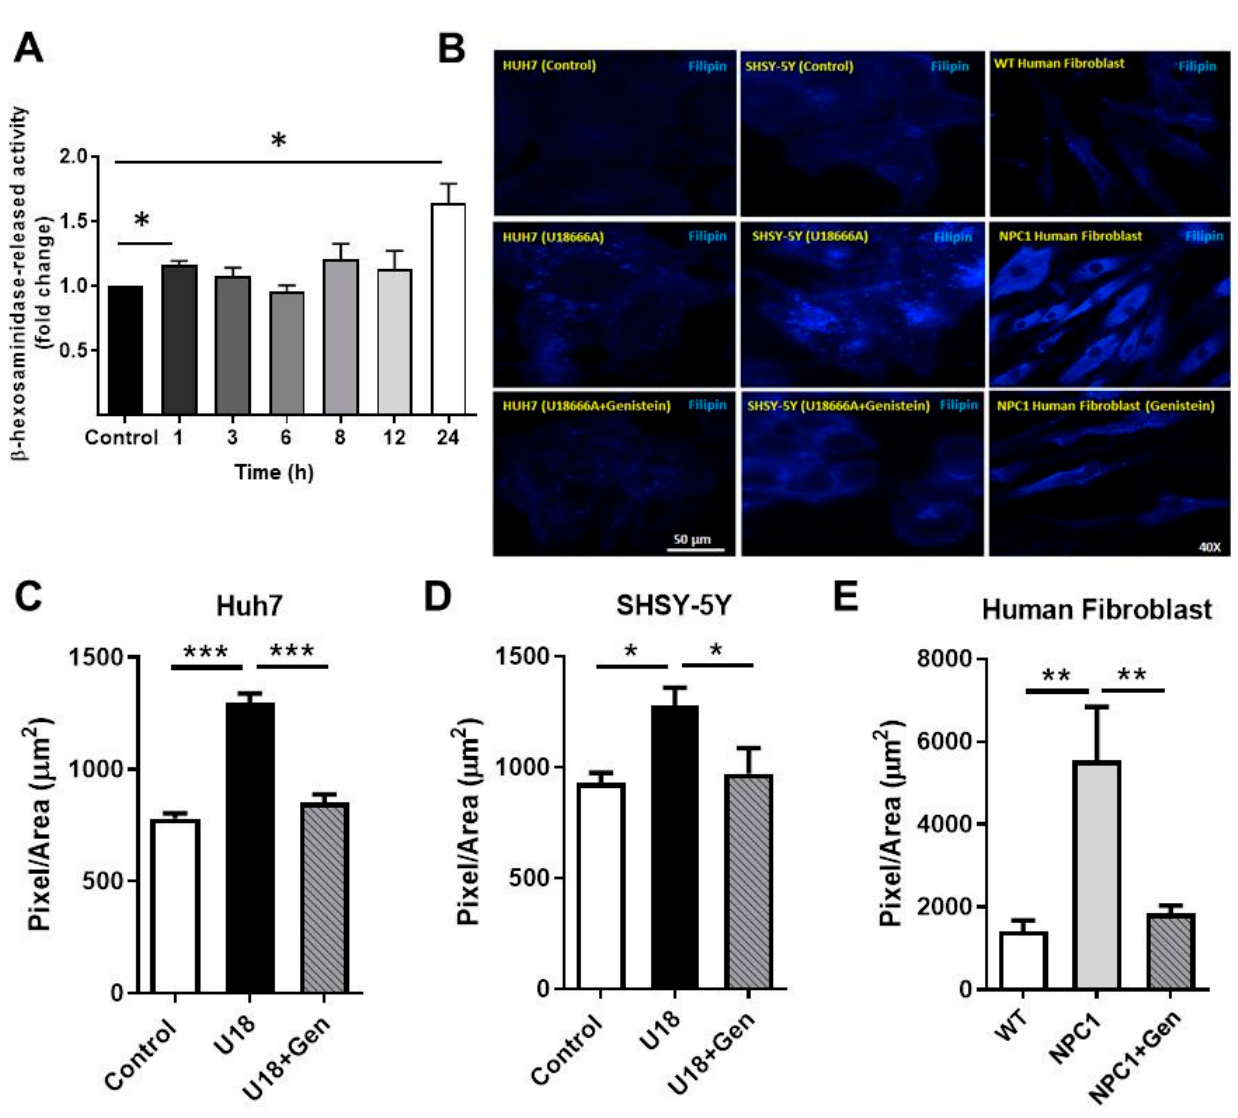
Figure 4. TFEB activation by genistein induces lysosomal exocytosis and reduces cholesterol accumulation in NPC models. ( A ) GM03123 NPC1 patient fibroblasts were cultured in 24-well plates at 30,000 cells/well and treated with 150 µ M genistein for 1, 3, 6, 8, 12, and 24 h. The activity of the lysosomal enzyme β -Hexosaminidase was determined in both conditioned media and cell extracts. The bar graphs show the released enzyme activity measured as a percentage of total activity and expressed as fold change. Data are mean ± SEM from independent experiments, each in triplicate. Representative images and quantification of cholesterol accumulation by filipin staining in Huh7 ( B , C ) and SHSY-5Y ( B – D ) cells in control condition, treated with U18 (0.5 µg/mL) and U18 and genistein and WT (control) and NPC1 patient fibroblasts ( B – E ) treated with genistein 150 µM for 24 h. The filipin intensity quantification was made by the Image J program. The bar graphs show mean ± SEM filipin signal intensity normalized to controls, n = 5 images/condition. * p ≤ 0.05, ** p ≤ 0.01, *** p ≤ 0.001 versus control analyzed by ANOVA with Tukey posttest.